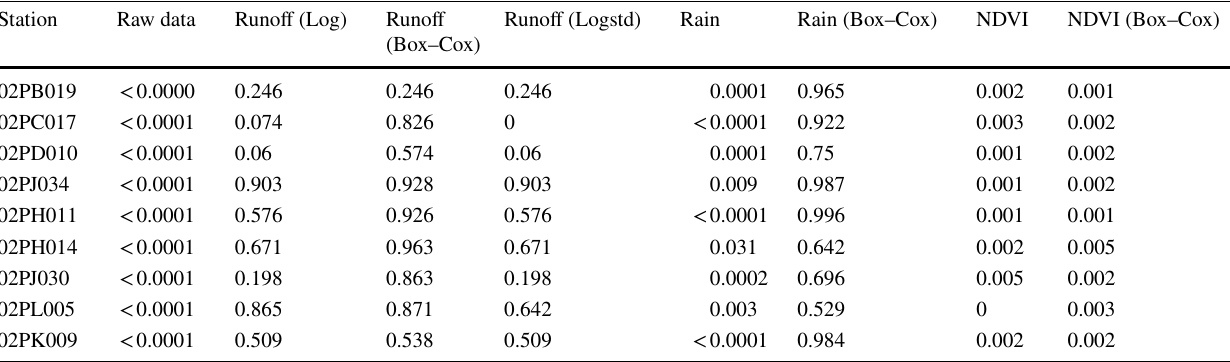
Table 3 J-B test results for all